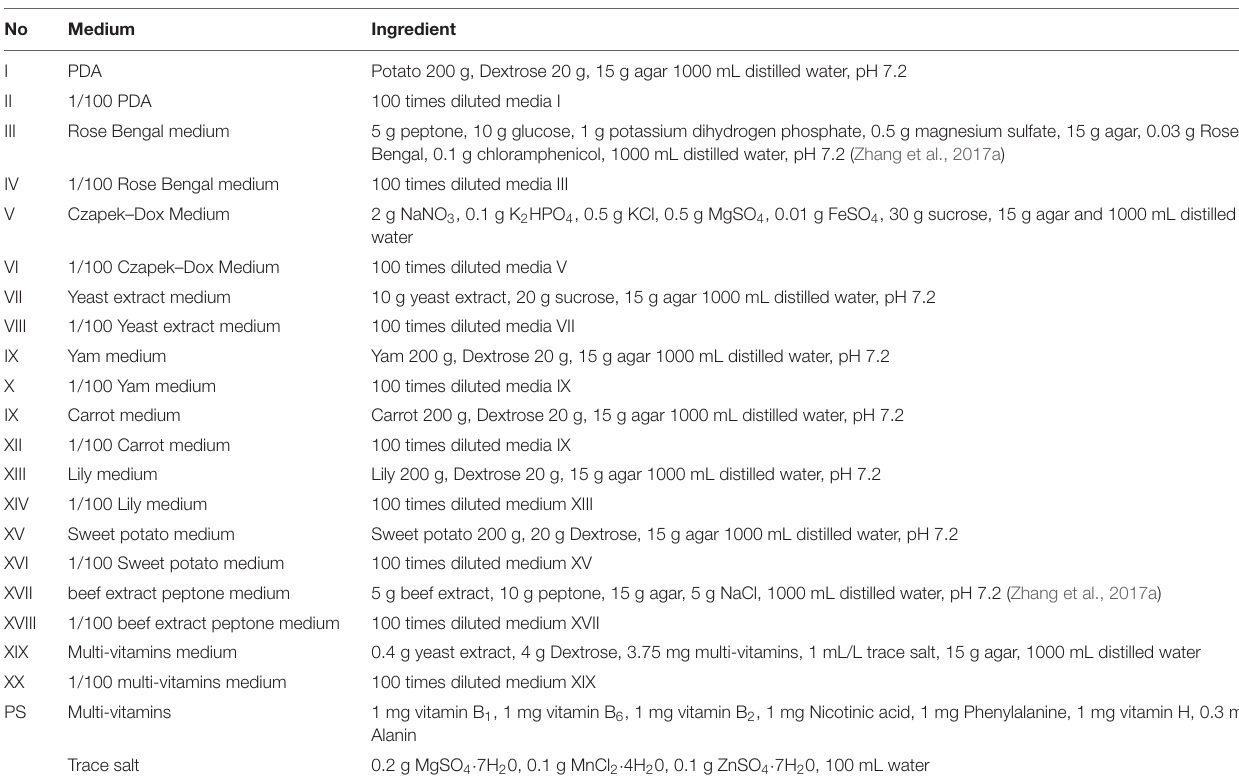
TABLE 1 | Twenty different media for endophyte